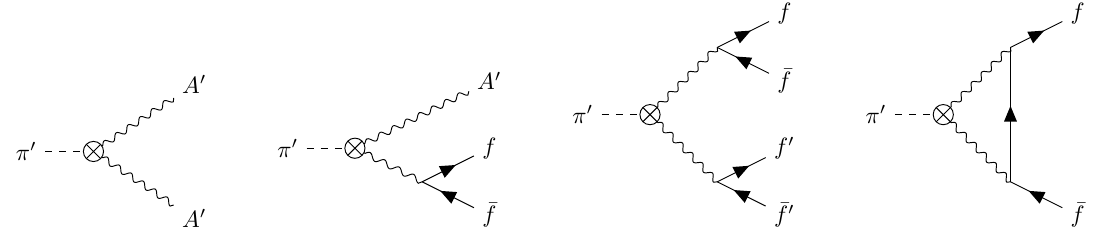
Figure 1 . Feynman diagrams for the dark pion decay to (off-shell) dark